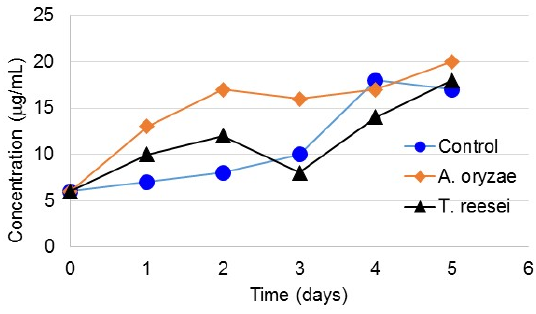
Figure 6. Content of glucose in soluble EPS extracts.